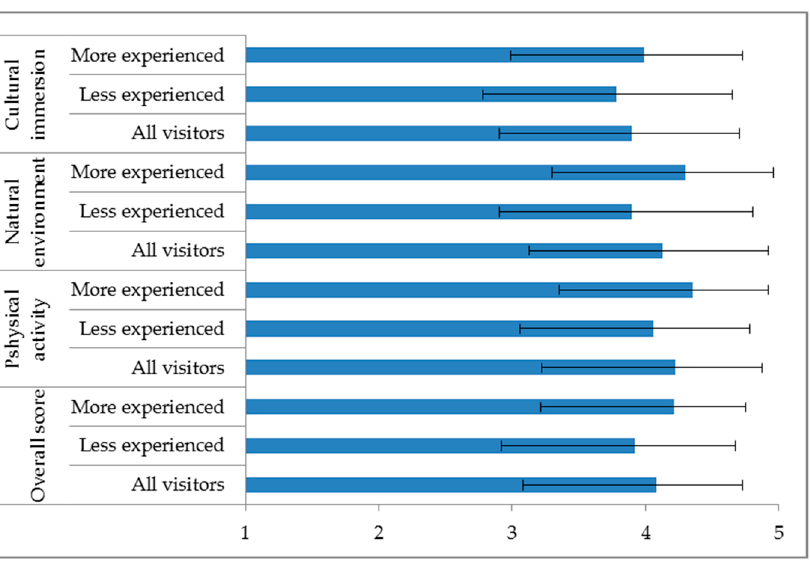
Figure 2. Average scores of motives.